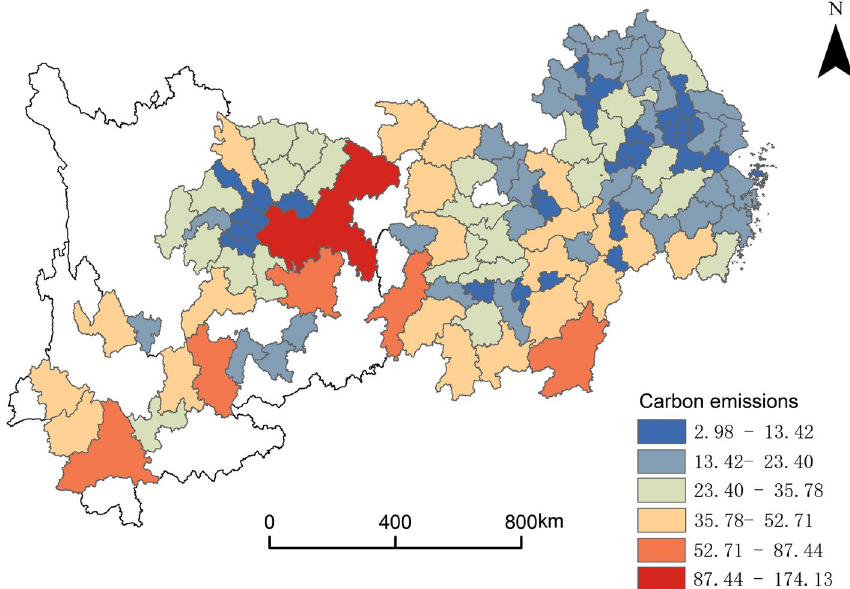
Figure 5. Current status of carbon emissions.